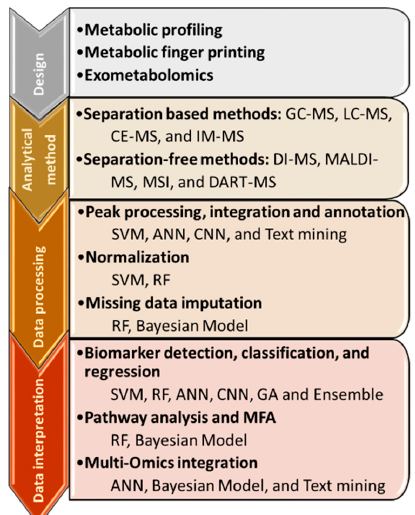
Figure 2. Mass spectrometry workflow with technical and analytical techniques. The MS investigation begins with the definition of the design of the experiment, whether a comprehensive